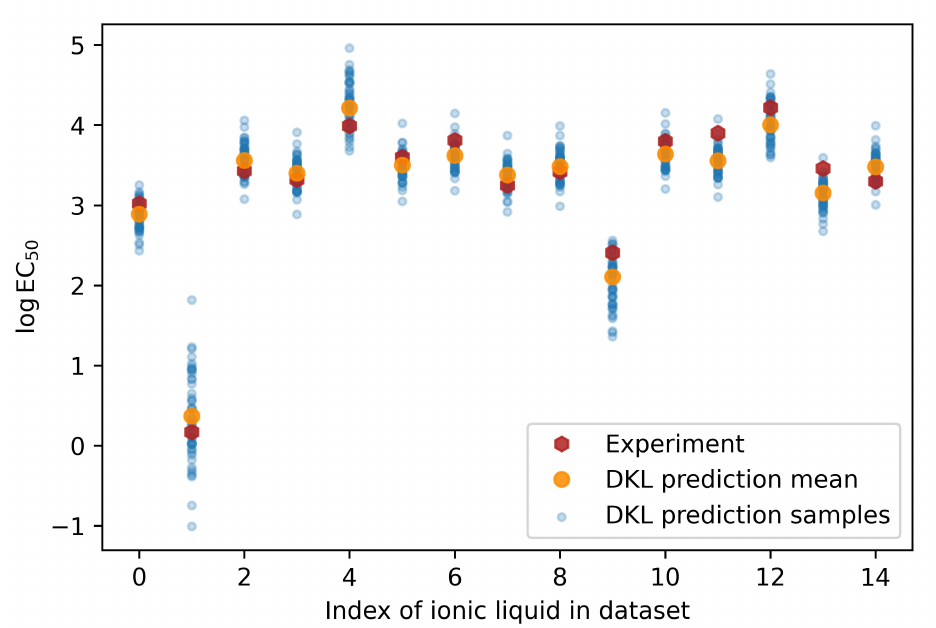
Figure 6. Comparisons between experiment and DKL predicted logEC 50 for each of the fifteen ionic liquids forming the test dataset. For each DKL prediction, we drew samples that contribute to the mean